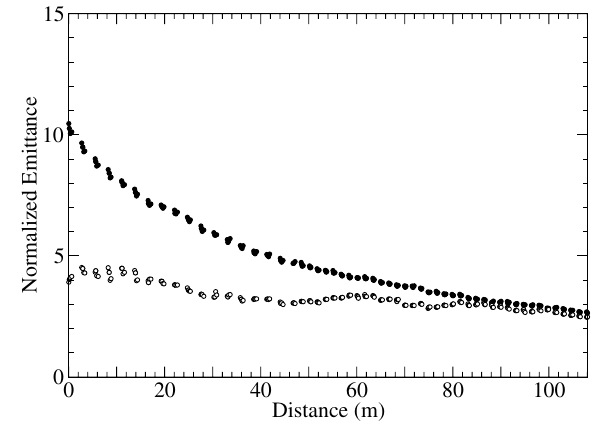
FIG. 19. The transverse (filled circles, in mm) and longitu- dinal (open circles, in cm) emittances, as a function of the distance down the cooling channel.